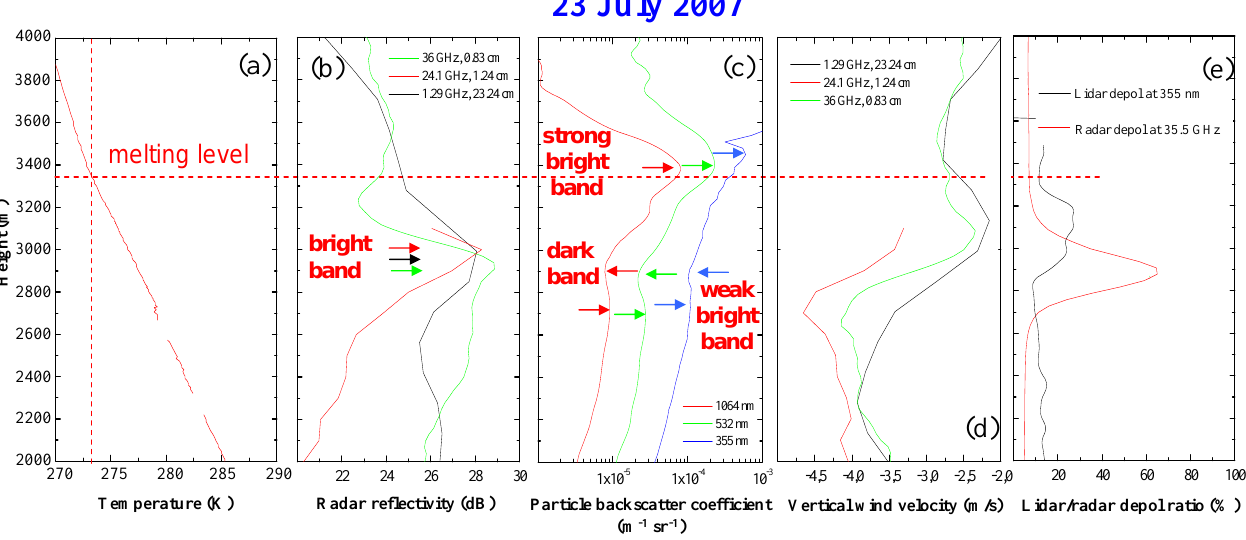
Fig. 7. Vertical profile of temperature as measured by the radiosonde launched at 14:06UTC (a) ; vertical profile of radar reflectivity at 35.5GHz, 24.15GHz and 1.29GHz ( b , data are averaged over the time interval 14:23–14:35UTC); vertical profile of backscattering coef- ficient at 355, 532 and 1064nm ( c , data averaged over the time interval 14:20–14:35UTC); vertical profile of vertical velocity measured at 35.5GHz and 1.29GHz ( d , data averaged over the time interval 14.23–14:35UTC); lidar (at 355nm) and radar (at 35.5GHz) depolarization ( e , lidar data averaged over the time interval 14:20–14:35UTC, radar data averaged over the time interval 14:23–14:35UTC). In panel a the range of radar reflectivities has been compressed by subtracting 15dBZ to the 1.29GHz